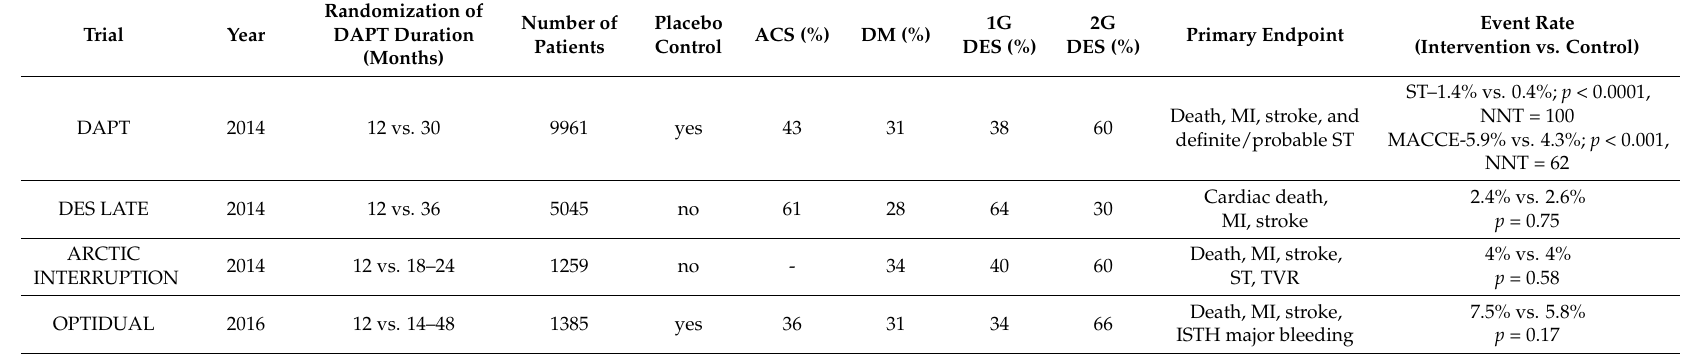
Table 5. Comparative features of randomized controlled trials (RCTs) for standard DAPT Vs. long DAPT